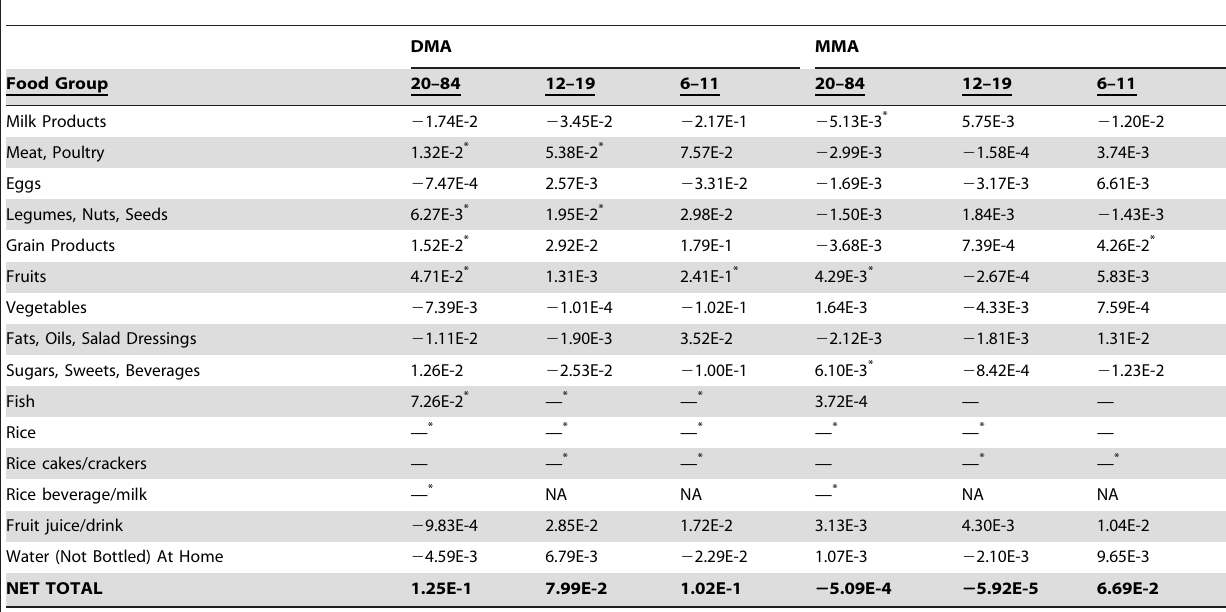
Table 7. Sample-weighted change in urinary methylated arsenic species [nmol/L per kg body weight] attributable to consuming each food group at the 90 th percentile amount estimated from NHANES 2003–2010